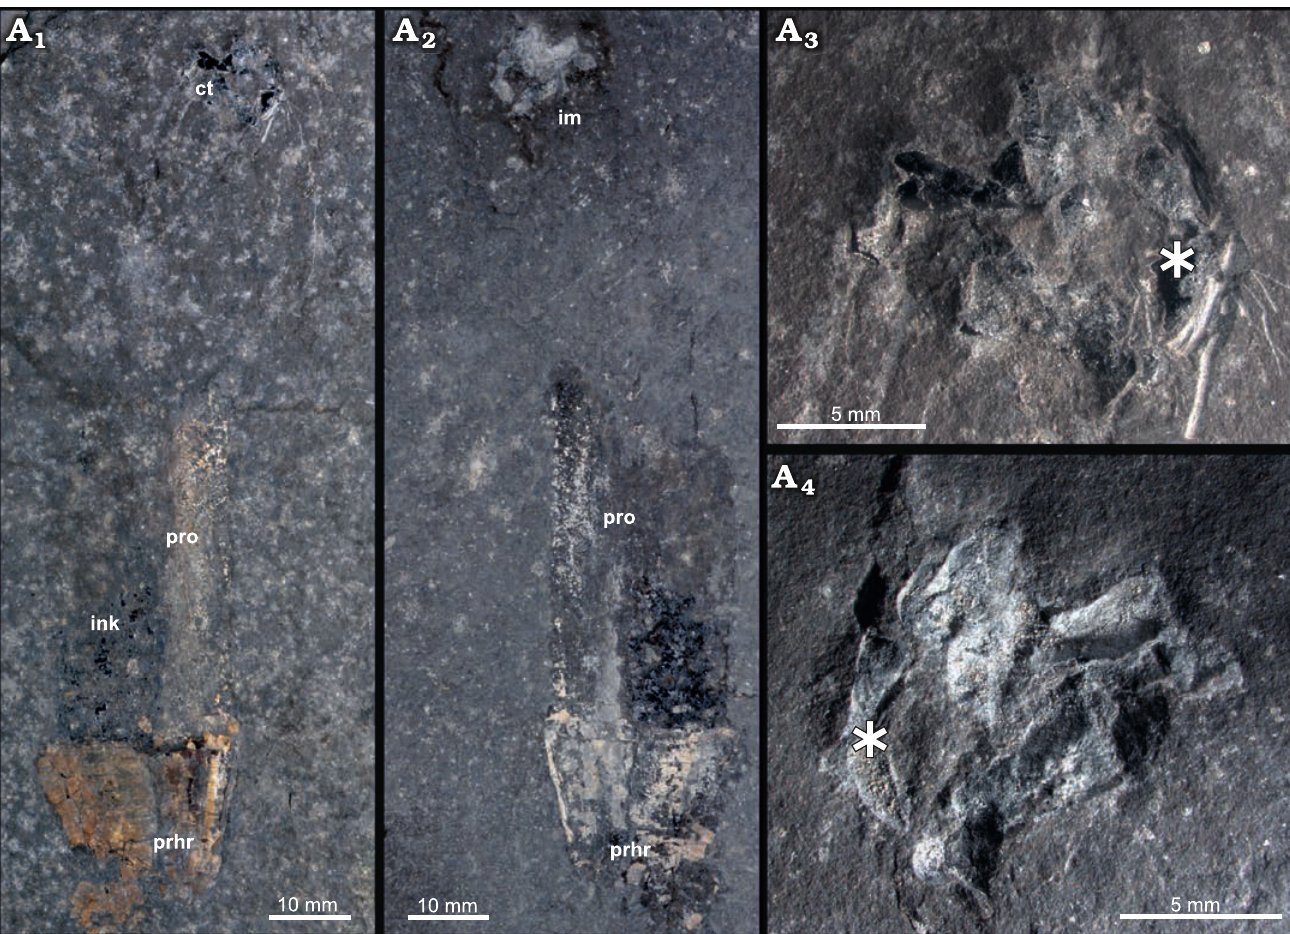
Fig. 1. Belemnoid cephalopod Phragmoteuthis bisinuata (Bronn, 1859), GBA 2006/011/0021, from the Carnian (Upper Triassic) of Raibl, Cave de Predil in Italy. A (part, GBA 2006/011/0021) and A (counterpart, GBA 2006/011/0028) were erroneously meant to show fish respectively teuthid prey of the adja- 1 2 cent P. bisinuata in Doguzhaeva et al. (2022). The supposed “teuthid gladius” remains represent the imprints of a cephalic cartilage seen on the counterpart, no visible traces of other fossil remnants; A , detail of GBA 2006/011/0021, determined as “fish remain” in Doguzhaeva et al. (2022) showing cartilage with 3 deep traces of preparation; A , detail of counterpart, GBA 2006/011/0028, determined as “teuthid gladius” in Doguzhaeva et al. (2022) lacking all morpho- 4 logical features which were described therein. Asterisk marks corresponding structures in A and A . Abbreviations: ct, cartilage; im, imprint of cartilage; 3 4 ink, ink sac; phr, phragmocone; pro,